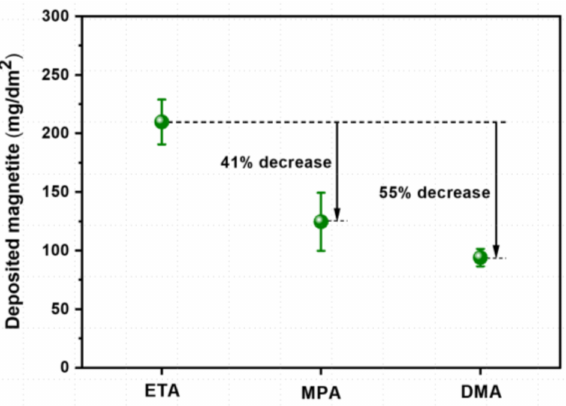
Figure 13. Amount of magnetite deposited on Alloy 690TT tubes depending on which of the three advanced amines was used (pH 270 ◦ C =